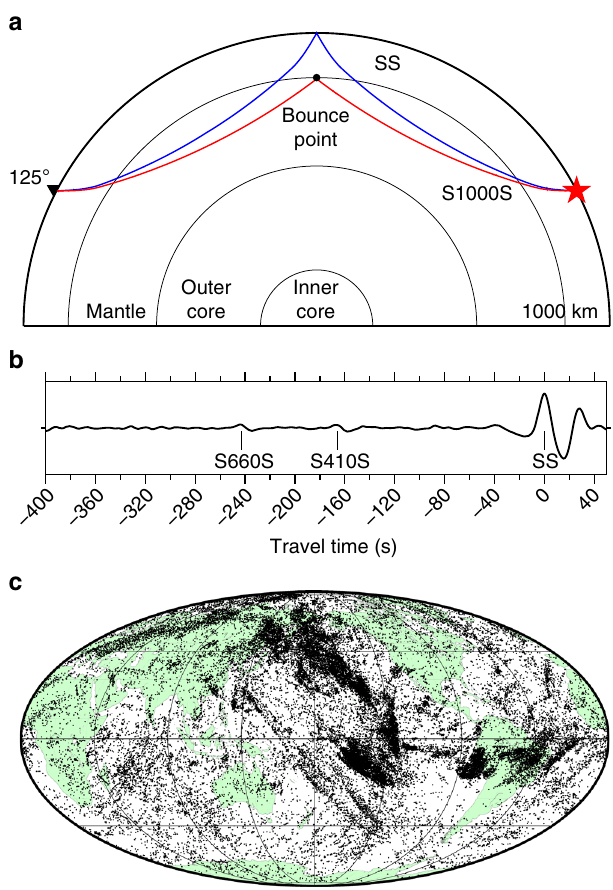
Fig. 1 SS data and coverage. a SS and S1000S ray paths. b Example of a high-quality SS seismogram (event: 1 January 2016, Indian-Antarctic ridge; station: DLRN). Precursors from 410 and 660 km are clearly visible.